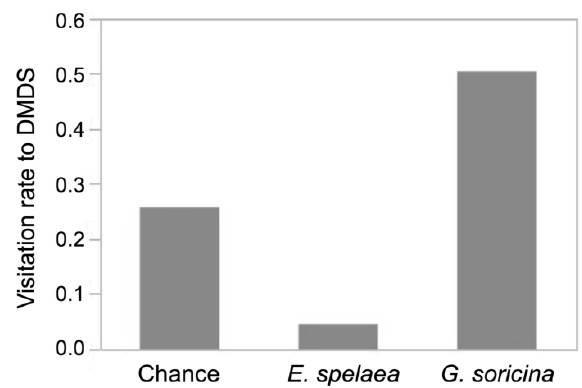
F IGURE 1. Observed and expected dimethyl disulphide selection rates. Rates of choices (probing with snout) to dimethyl disulphide odour cues are shown for the palaeotropical bat Eonycteris spelaea, alongside the expected levels based on chance and choices by the neotropical bat Glossophaga